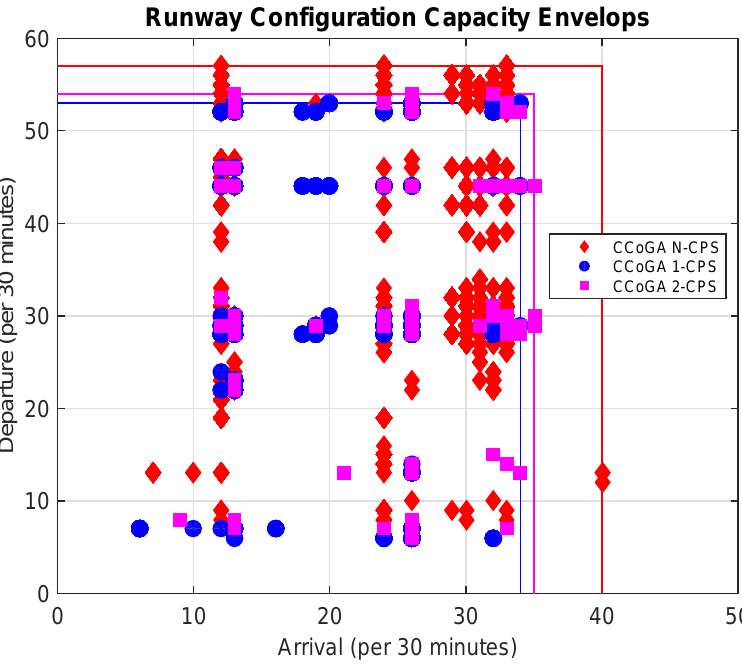
Figure 12. Runway configuration capacity